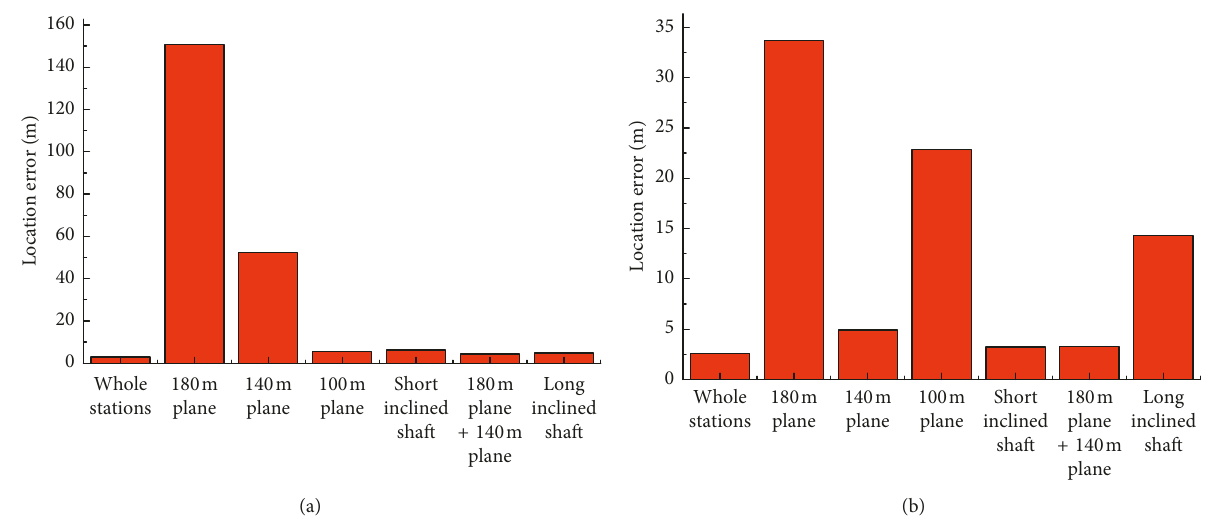
Figure 11: Relationship between the location error and the sensor position. (a) 100m plane seismic source location error. (b) 140m plane seismic source location error.